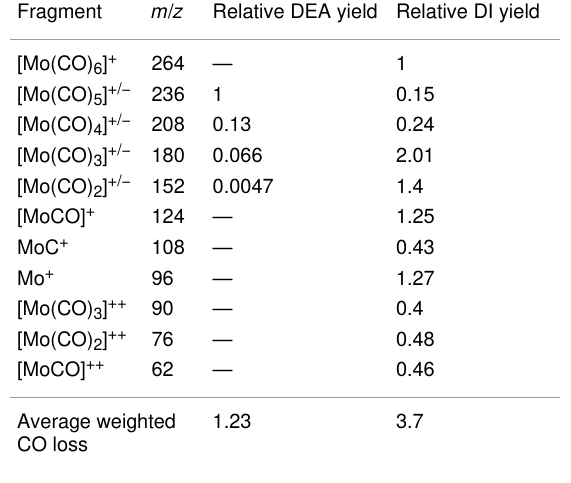
Table 2: Relative yields of Mo-containing ions formed by DEA and DI to Mo(CO) 6 and average weighted CO loss per DEA and DI incident. Fragment